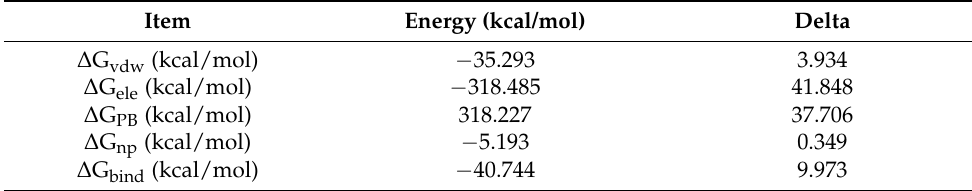
Table 1. Binding free energy between heparin and OR2C1.